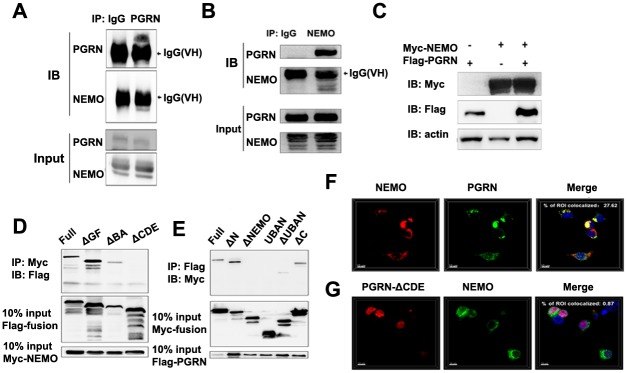
PGRN binds to NEMO.(A) HEK293 cells were infected with PR8 virus at an MOI of 1. Cell lysates were immunoprecipitated with anti-PGRN antibody and probed with anti-NEMO antibody. (B) HEK293 cells were infected with PR8 virus at an MOI of 1. Cell lysates were immunoprecipitated with anti-NEMO antibody and probed with anti-PGRN antibody. (C) HEK293 cells were mock transfected or transfected with vectors encoding FLAG-tagged PGRN for 24 h. Cell lysates were analyzed by immunoblotting with an anti-NEMO antibody. (D) Co-IP analysis of the interaction between Myc-tagged NEMO and FLAG-tagged full-length or mutant PGRN in HEK293 cells. (E) Co-IP analysis of the interaction between FLAG-tagged PGRN and Myc-tagged full-length or mutant NEMO in HEK293 cells. (F) Confocal microscopy of HEK293 cells co-transfected with plasmids encoding FLAG-tagged PGRN and Myc-tagged NEMO and stained with Alexa Fluor 488-conjugated anti-FLAG antibody (green) and Alexa Fluor 555-conjugated anti-Myc antibody (red). The DAPI serves as a marker for nuclei (blue). (G) Confocal microscopy of HEK293 cells co-transfected with vectors encoding FLAG-tagged PGRN mutants and Myc-tagged NEMO. All data are representative of three independent experiments showing similar results.